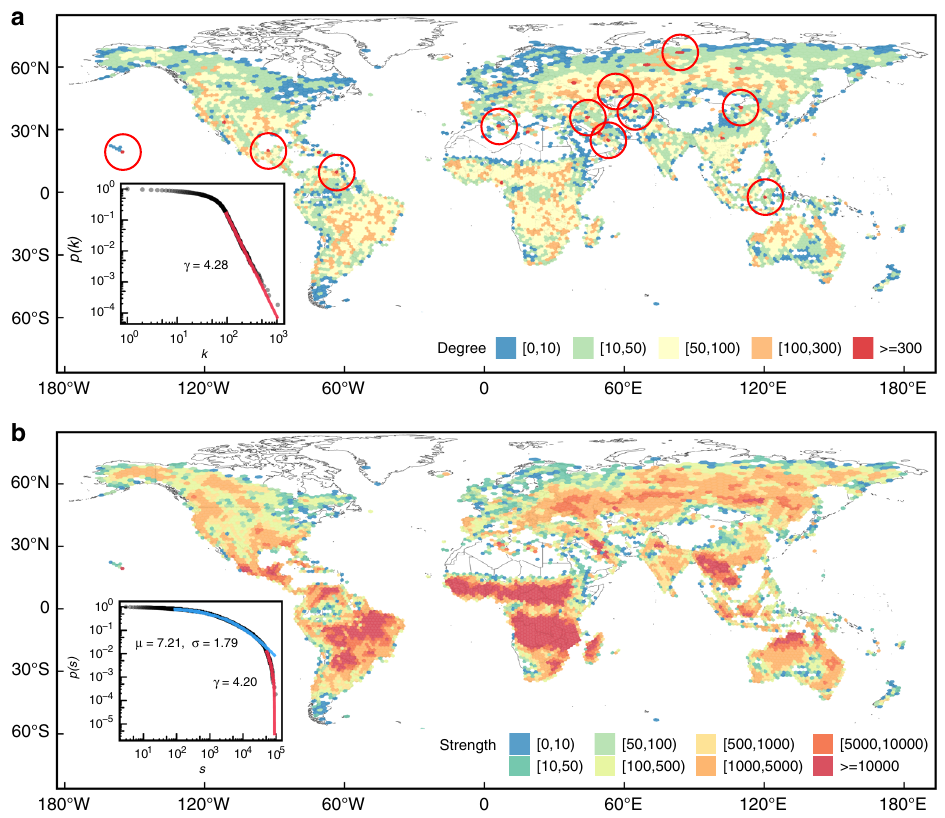
Fig. 6 The degree and strength distributions for the chronnet constructed with the wild fi re data set. a Degree and b strength distributions. A small pruning threshold τ = 2 was considered. The red circles ( a ) mark the 2% of higher degree nodes. The inner plots show the probability distributions. Red and blue lines illustrate the fi t of power-law and log-normal distribution, respectively 39